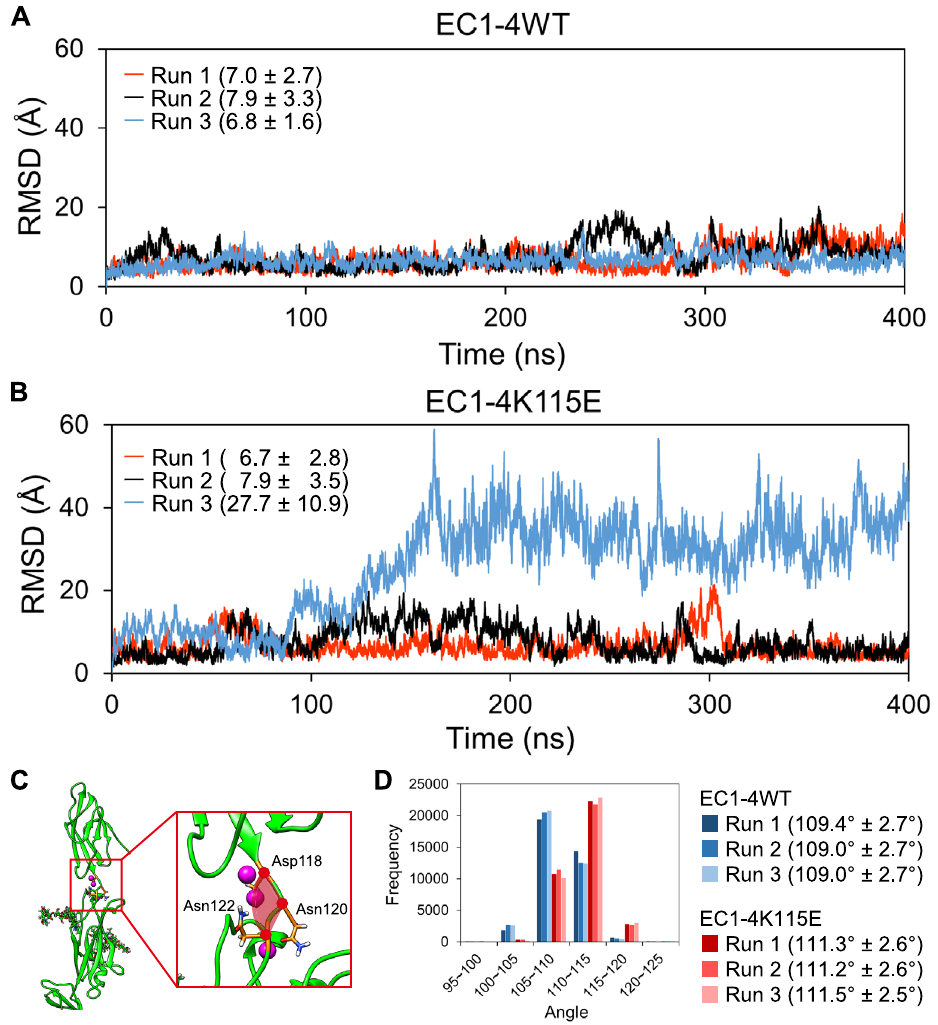
Figure 5. ( A ) Root-mean-square deviation (RMSD) values of Cα atoms of chain B after superposing those of chain A in the ( A ). EC1-4WT homodimer or ( B ). EC1-4K115E homodimer. Averages and standard deviations from 40 to 400 ns of each simulation are shown in the graph in angstrom units. ( C ) Angle indicated in red was calculated. ( D ) Angle between Asp118, Asn120, and Asn122 was calculated using the GROMACS tool. Averages and standard deviations from 40 to 400 ns of each simulation are shown in